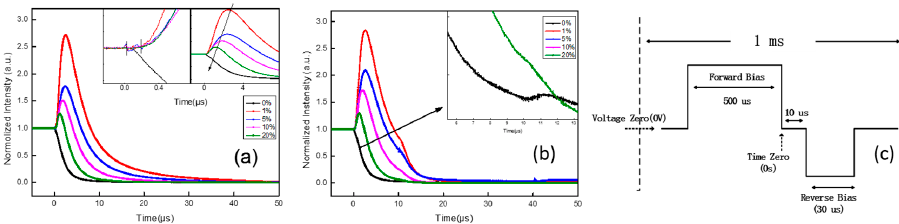
Figure 3. The transient EL curves of 4CzIPN-doped devices with different concentrations; inset is an enlarged view of the transient curves, respectively: ( a ) without a reverse bias pulse; ( b ) with a delay time of 10 μ s and a reverse bias of 5 V; ( c ) is the timing scheme used in transient EL measurements.